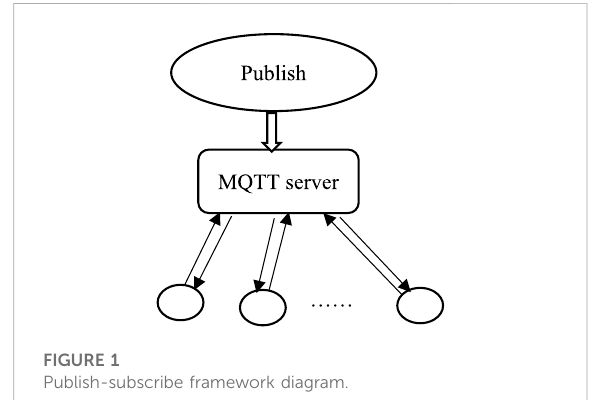
FIGURE 1 Publish-subscribe framework